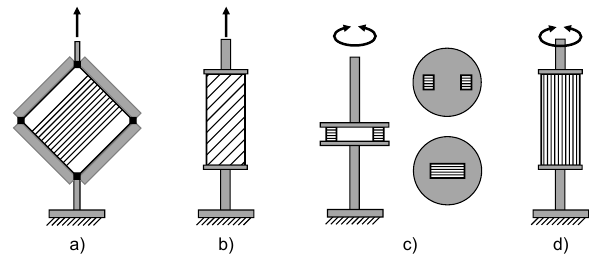
Figure 1: Test principles for longitudinal intra-ply shear characteri- zation (as described in [9, 10], and [13]): a) picture-frame test setup; b) off-axis tension test setup; c) rotational parallel platens test method; d) torsion bar test